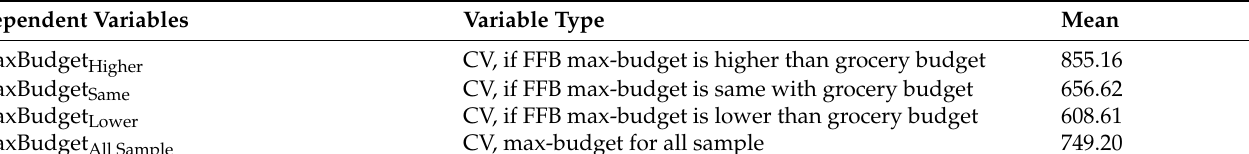
Table 1. The Summary of Descriptive Statistics and Variable Definition ( n =